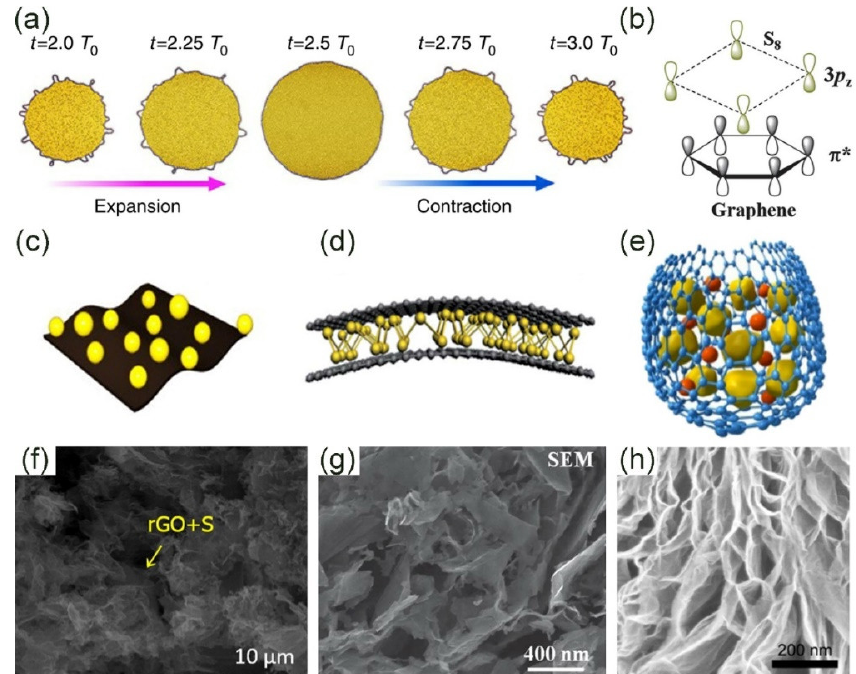
Figure 1. Interaction between graphene and sulfur and its configuration. ( a ) Macroscopic volume change of graphene-coated sulfur particles [35]. Copyright 2014, Springer Nature. ( b ) Microscopic symmetry and non-polarity of graphene and sulfur [36]. Copyright 2013, Royal Society of Chemistry. ( c ) The in-plane structure has the advantage of flexible electrodes [38]. Copyright 2016, Elsevier. ( d ) Sandwich structure: sulfur is confined between two or more layers of graphene sheets [36]. Copyright 2013, Royal Society of Chemistry. ( e ) Core-shell structure: sulfur and LiPSs are coated by graphene to prevent leakage [39]. Copyright 2013, Elsevier. ( f ) Scanning Electron Microscope (SEM) image of complex of sulfur and graphene oxide (S/GO) [38]. Copyright 2016, Elsevier. ( g ) The sandwich structure of sulfur is evenly distributed on the graphene sheet [36]. Copyright 2013, Royal Society of Chemistry. ( h ) SEM image of core-shell structure [39]. Copyright 2013, Elsevier.